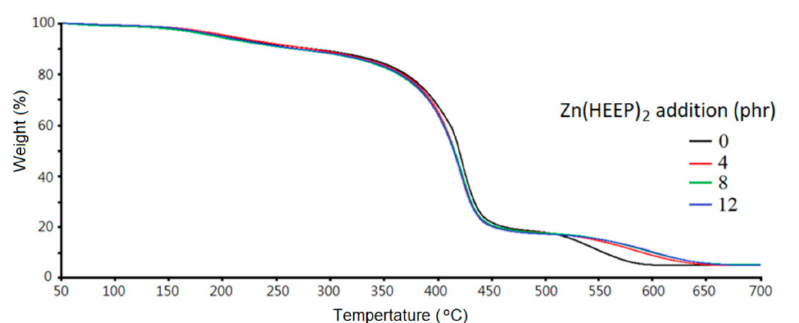
Figure 8. TGA curves of UV films with different Zn(HEEP) 2 additions.